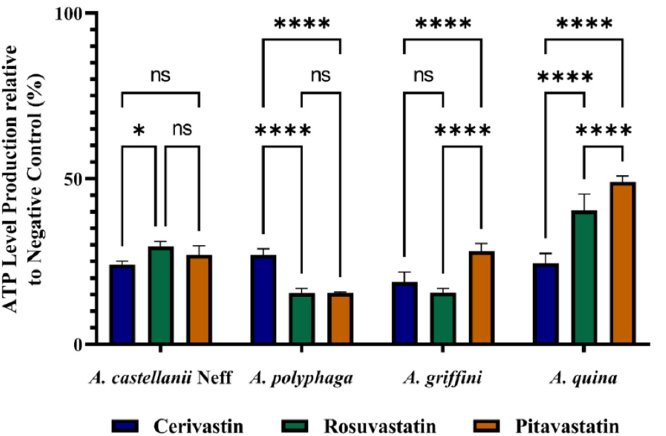
Figure 3. Effect of IC 90 of statins on the ATP production of Acanthamoeba castellanii Neff, A. polyphaga , A. griffini and A. quina trophozoites, using CellTiter-Glo ® luminescent cell viability assay. Results are represented as percentages relative to the negative control. Differences between the values were assessed using one-way analysis of variance (ANOVA). Data are presented as means ± SD (N = 3); NS, non-significant. * p < 0.05 and **** p < 0.0001 are significance differences when comparing the different mean values.